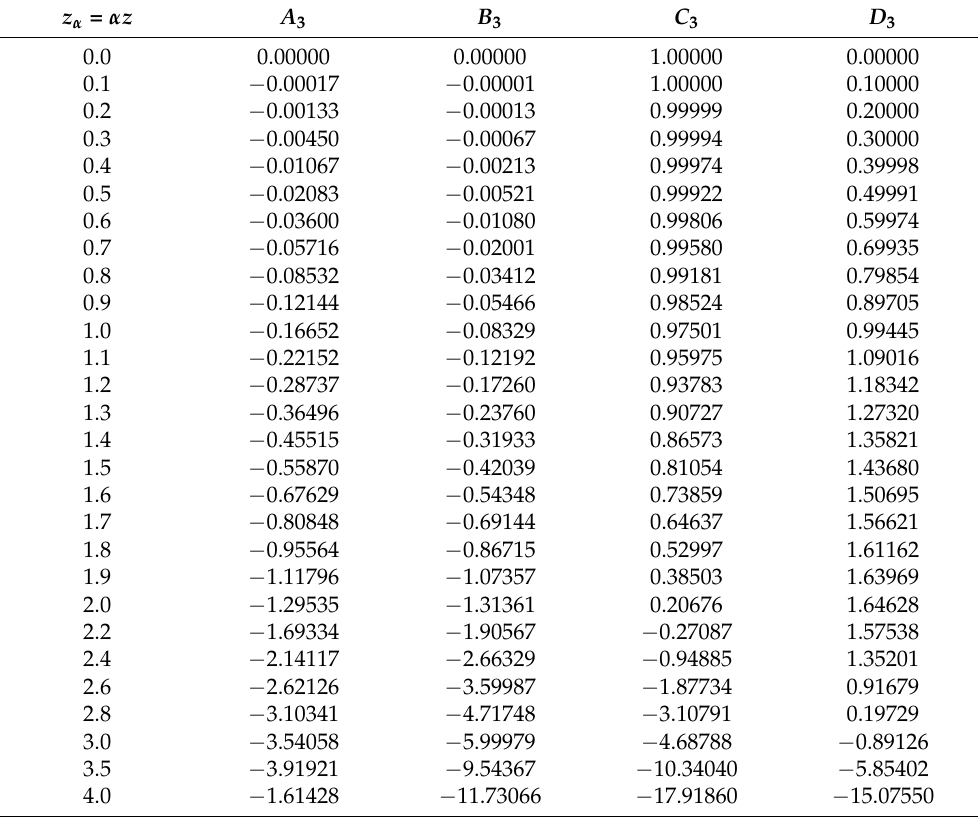
Table A3. Dimensionless coefficient of pile responses ( A 3 , B 3 , C 3 , and D 3 ).